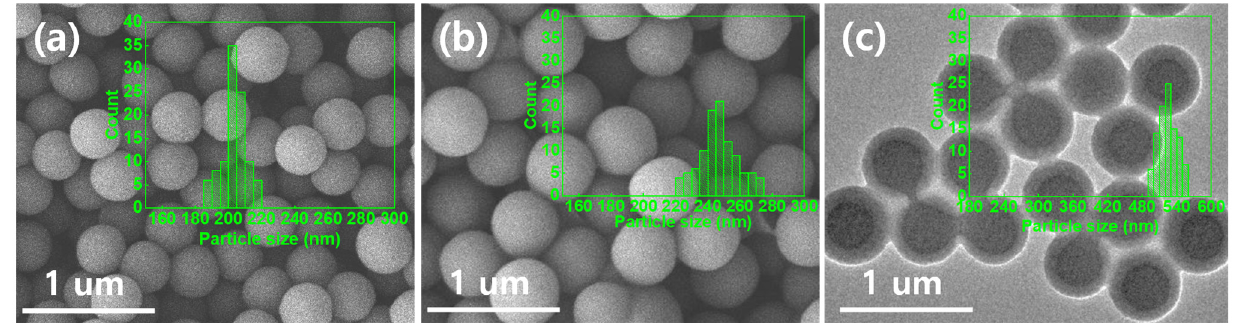
Figure 1. Scanning electron microscopy (SEM) images of PSMA nanoparticles prepared with different maleic anhydride (MA) ratios: ( a ) 5 and ( b ) 30 wt%. ( c ) Transmission electron microscopy (TEM) image of PSMA/PEI core–shell nanoparticles.